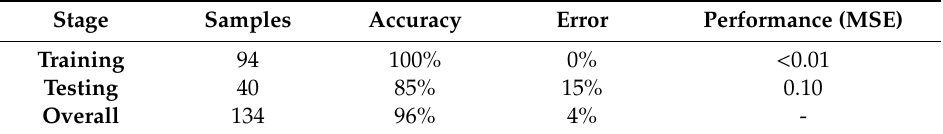
Table 1. Results of the artificial neural networks pattern recognition model (Model 1) showing the accuracy, error, and performance based on means squared error (MSE) for each stage for the selection of cutoff frequency related to low, medium, and high respiration rate signals from computer vision analysis.